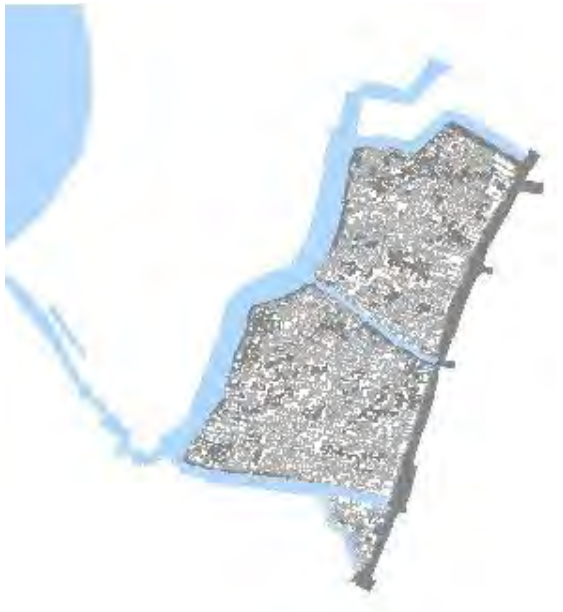
Figure 2. Gazdhar Bandh Layout